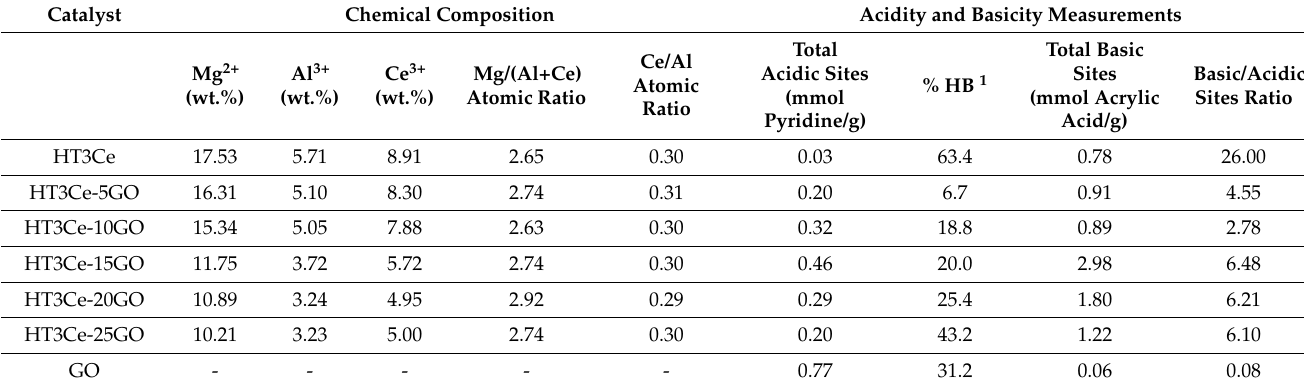
Table 1. Chemical composition determined by XRF and the results of acidity-basicity measurements. Catalyst Chemical Composition Acidity and Basicity